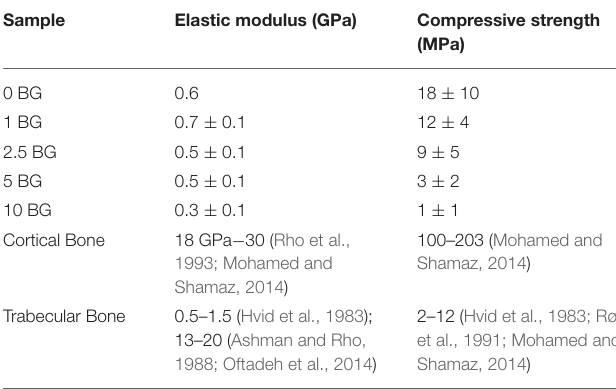
TABLE 1 | Mechanical properties of PLA-BG